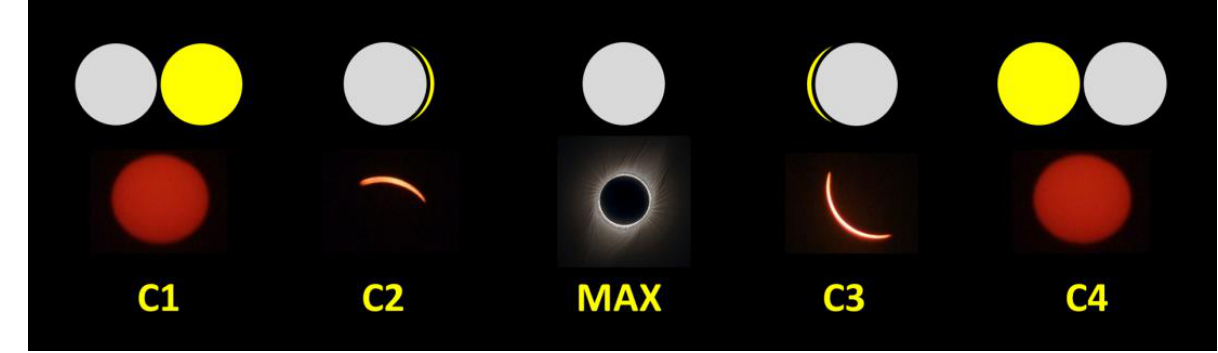
Figure 2. Stages of a solar eclipse. C1 and C4 mark the beginning and end of eclipse, respectively. C2 and C3 mark beginning and end of annular or total eclipse during these cases.